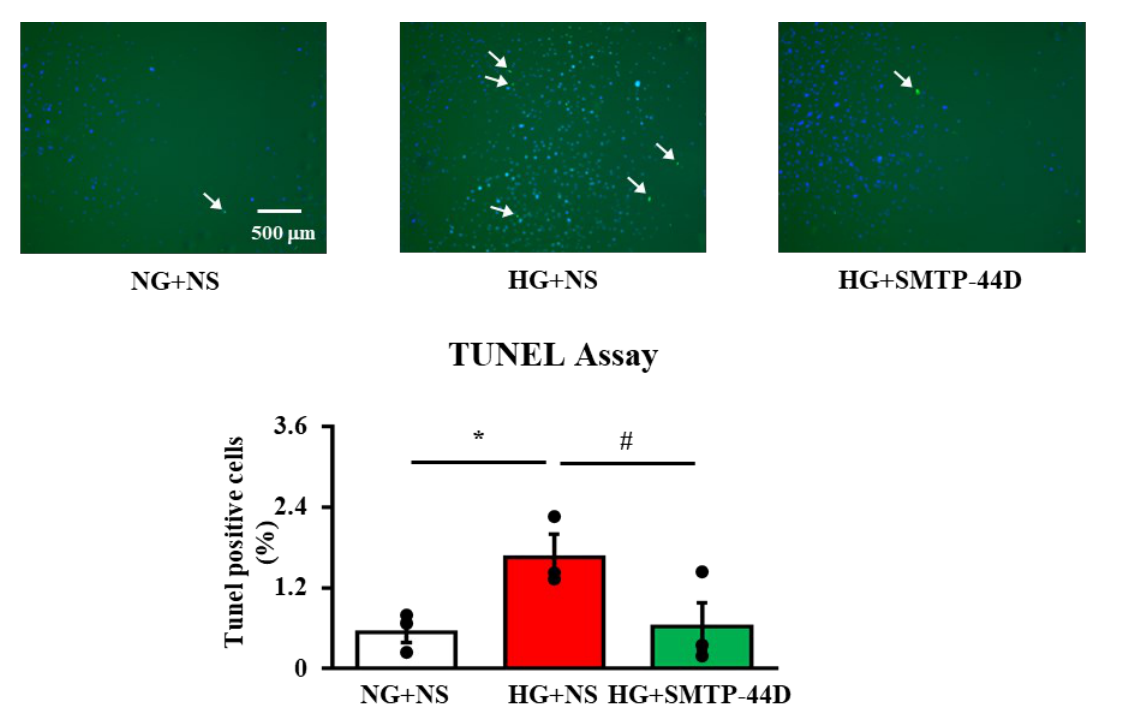
Figure 4. Evaluation of apoptosis in response to SMTP-44D in IMS32 cells under high glucose conditions. IMS32 cells were incubated with SMTP-44D (30 µ M) from 48 to 96 h after the HG treatment. Apoptosis analysis by the TUNEL assay was performed 96 h after the HG treatment. Representative images of TUNEL-positive cells (green fluorescence) labeled with dUTP and nuclei (blue fluorescence) stained with DAPI solution are shown. White arrows indicate TUNEL-positive cells. The data are expressed as the mean ± S. E. M. ( n = 3). * p < 0.05 vs. NG + NS group; # p < 0.05 vs. HG + NS group by one-way analysis of variance followed by Bonferroni test. NG, normal glucose; HG, high glucose; NS, normal